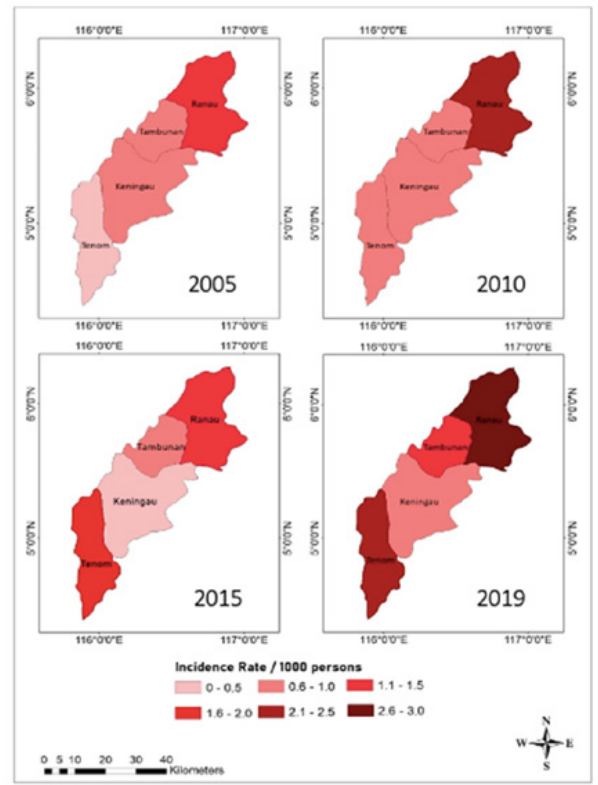
Fig. 3: Spatial distribution of malaria incidence rate per 1000 persons in each selected district of Sabah